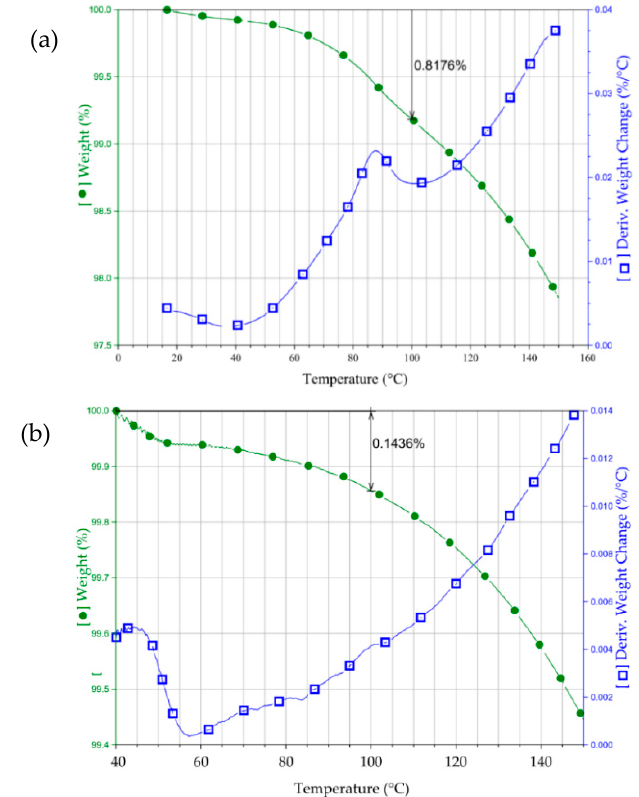
Figure 8. Moisture investigation of guayule resin by TGA: ( a ) As-received material, and ( b ) after 4 hr heat treatment at 160 °C, and 600 rpm.